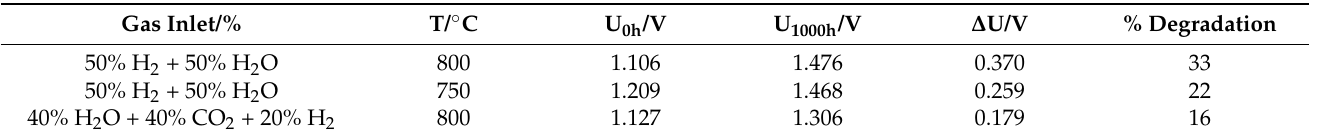
Table 1. Overview of the absolute voltage increase after 1000 h degradation test depending on measurement